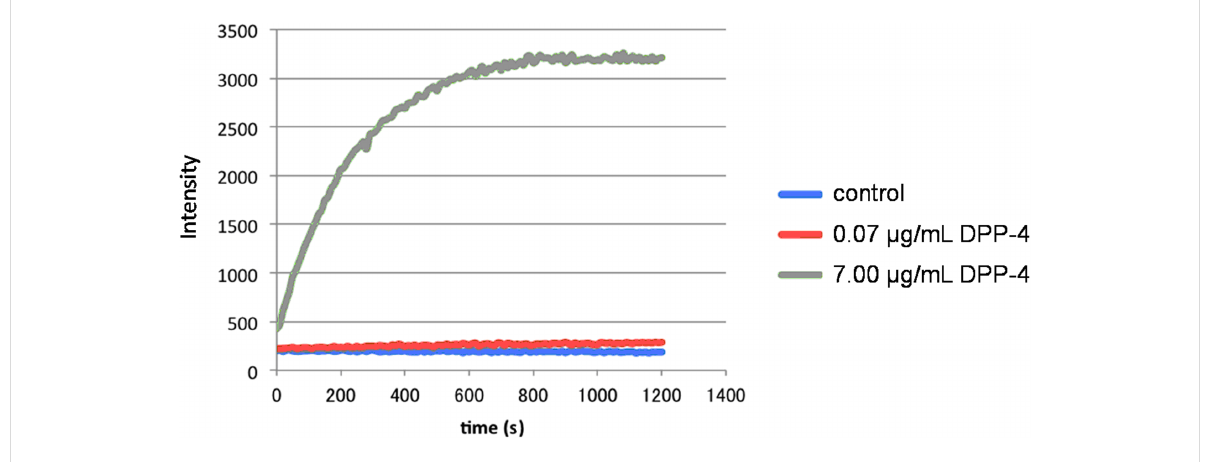
Figure 4: Fluorescence intensity changes of H-Gly-Pro- 1 on addition of DPP-4.